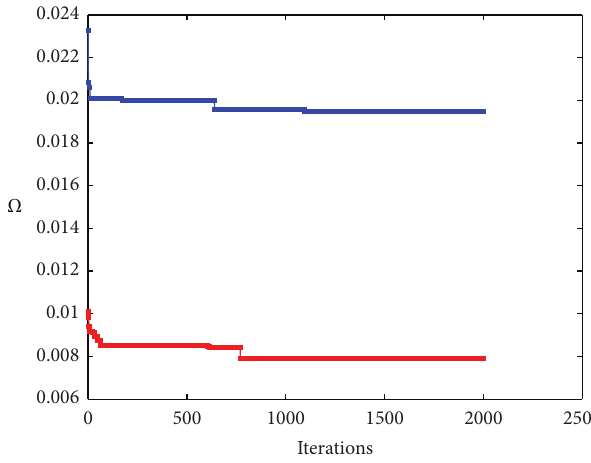
Figure 5: Fitting error evolution of the Ω operator for the outer curve (in blue) and the inner curve (in red) of the paint spray gun example for 2000